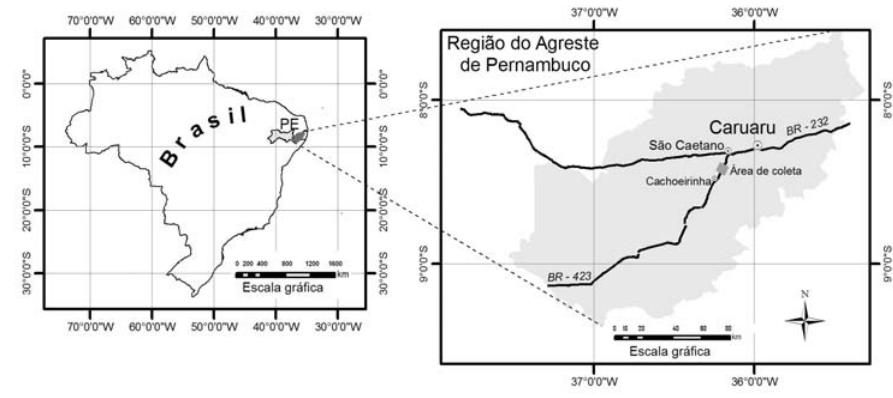
Figura 1. Localização da área de